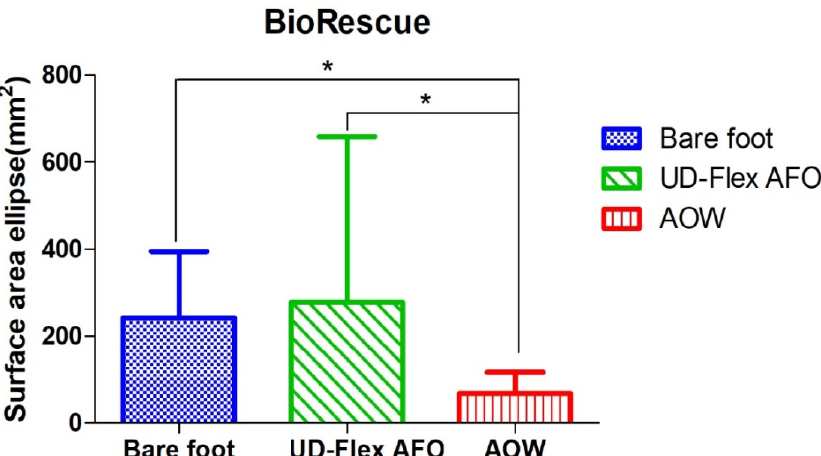
Figure 6. Comparison of static balance among the three conditions using BioRescue. AFO: ankle–foot orthosis; AOW: ankle–foot orthosis with wire. * p < 0.05.